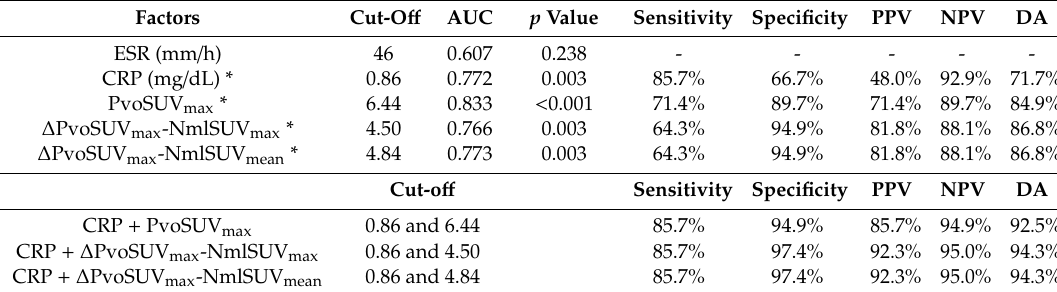
Table 5. Diagnostic values of FDG-PET and CRP for residual